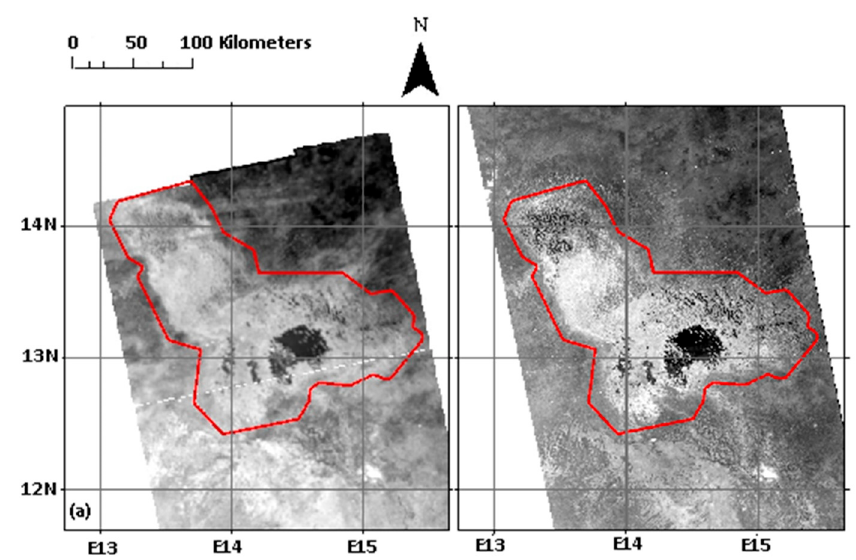
Figure 5. Example ESA Sentinel-1a C-band radar acquisitions, ( a ) wet season (16 July 2015) ( b ) dry season (9 April 2015). Table 2. Lake Chad area calculations by subdivision of lake for 18 available pairs of ESA Sentinel-1a C-band radar and corresponding NASA MODIS Land Surface Temperature (LST) data. Average Total Surface Water Area Radar (sq.